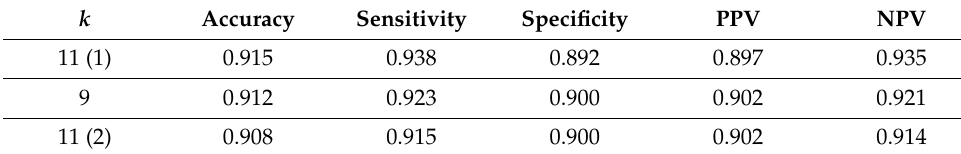
Table 14. Evaluation of the chosen classifiers performance in Substage 2. k